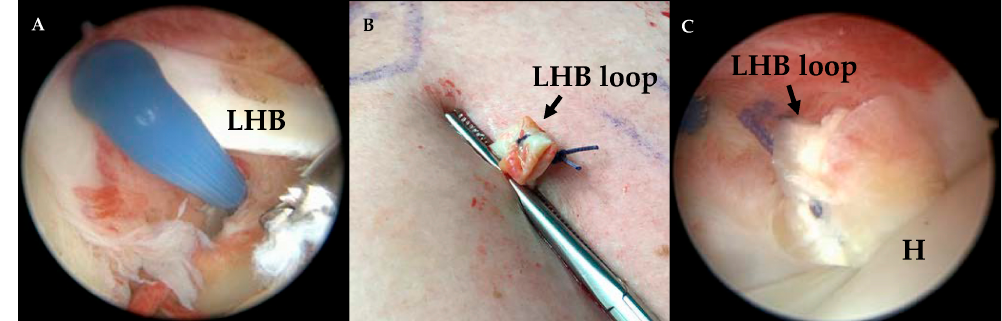
Figure 1. Right shoulder from the posterior portal with the patient placed in beach chair position. ( A ) Tenotomy of the biceps tendon close to its insertion; the biceps tendon is pulled extraarticularly through the anterolateral portal. ( B ) Long biceps tendon after extracorporeal creation of the loop and fixation with suture. ( C ) Long biceps tendon loop locked at the entrance of the bicipital groove (H, humeral head; LHB, long head of biceps.).